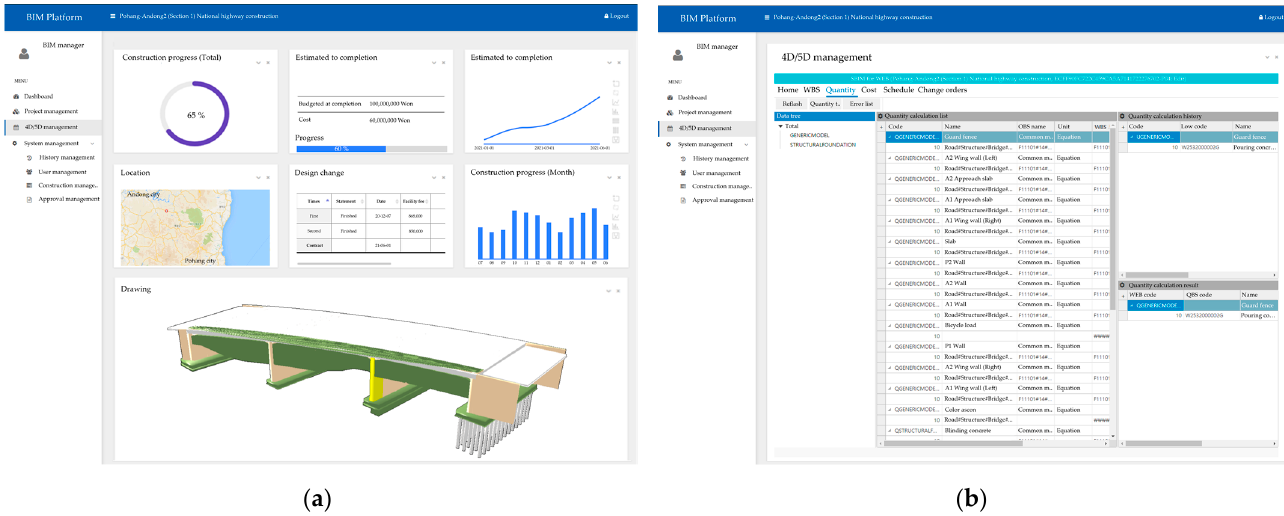
Figure 3. Representative page of web-based infrastructure BIM platform: ( a ) dashboard and ( b ) quantity takeoff page.